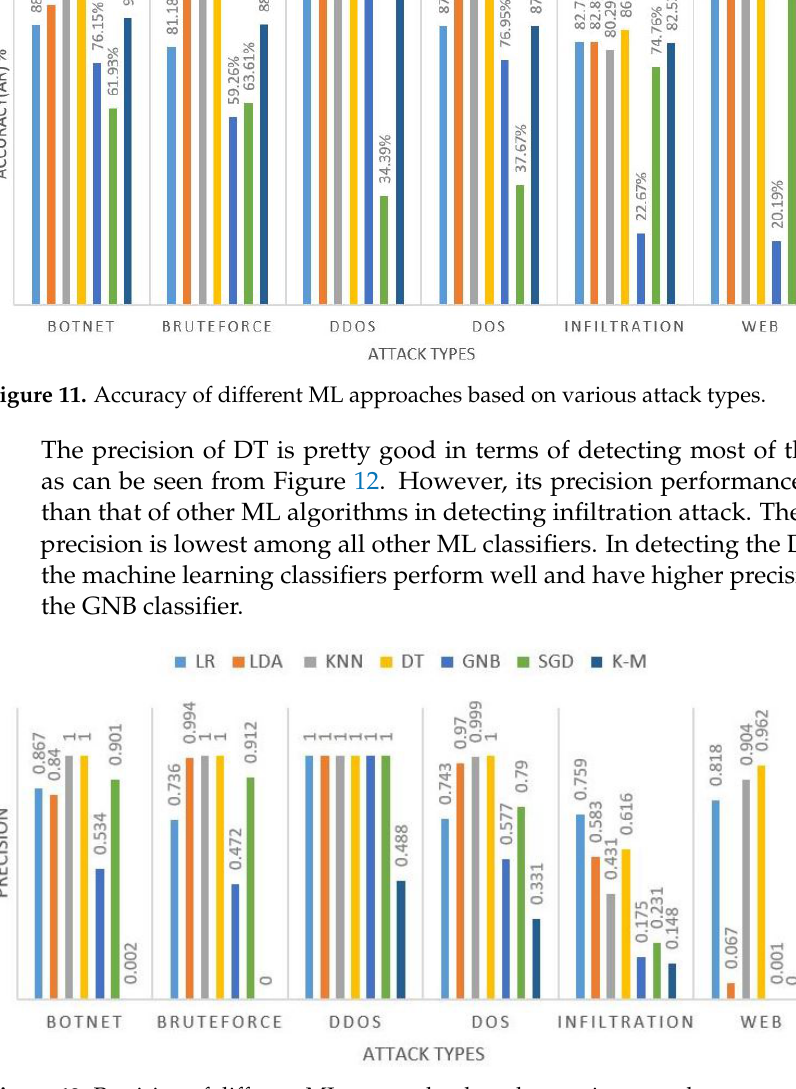
Figure 12. Precision of different ML approaches based on various attack